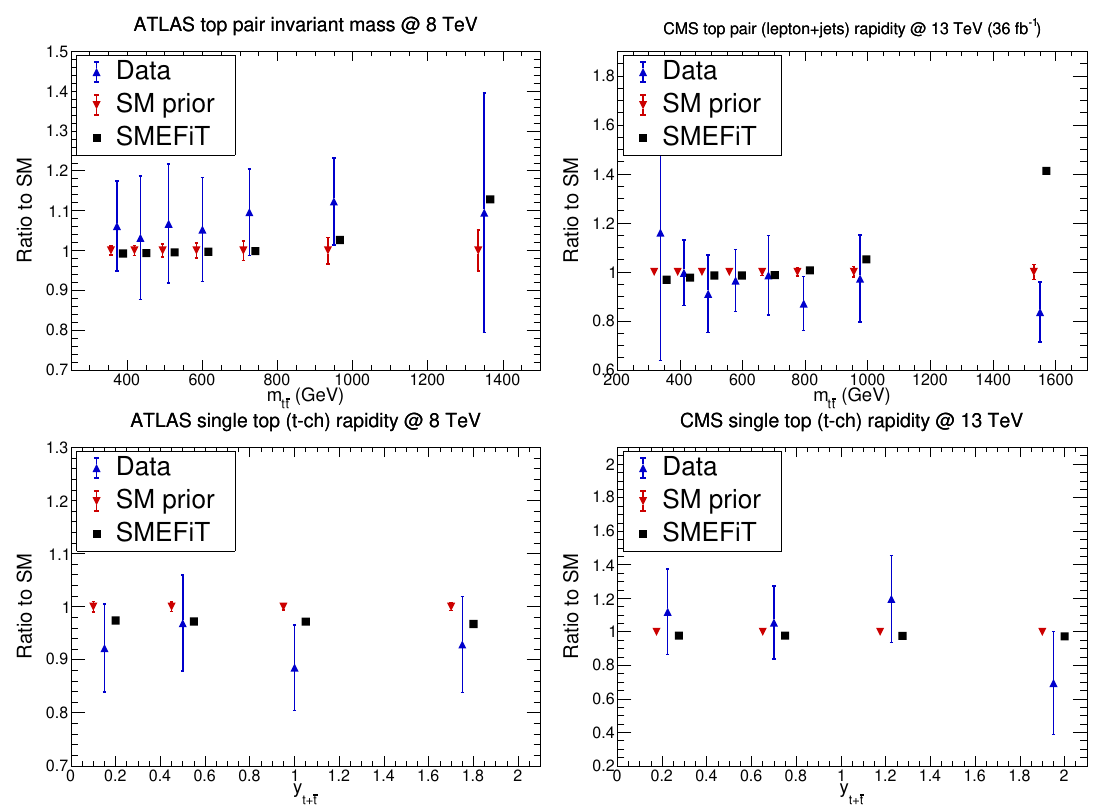
Figure 14 . Same as (cid:12)gure 13, now for di(cid:11)erential distributions in inclusive top quark pair and single top t -channel production. From left to right and from top to bottom we show the invariant mass distribution in t (cid:22) t production in ATLAS at 8 TeV, the rapidity distribution in t (cid:22) t production in CMS at 13 TeV (from the 2016 dataset based on = 36 fb (cid:0) 1 ), and the rapidity distributions for L the t + (cid:22) t sum in single top quark production in the t -channel from ATLAS at 8 TeV and from CMS at 13 TeV.